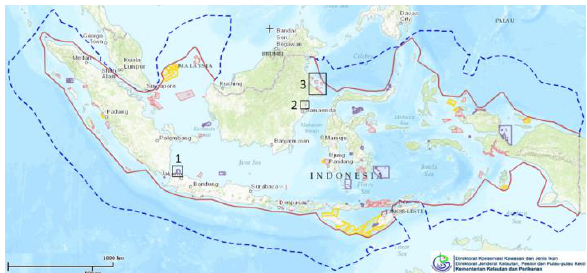
Figure 2. Marine Protected Areas (MPA) in Indonesia. The red line marks the territorial border, the dashed blue line the EEZ. The color of the MPA (hatched areas) denotes the national responsibility. Three MPA are marked by black rectangles: 1: ‘Seribu Islands’; 2: ‘South Bontang’; 3: